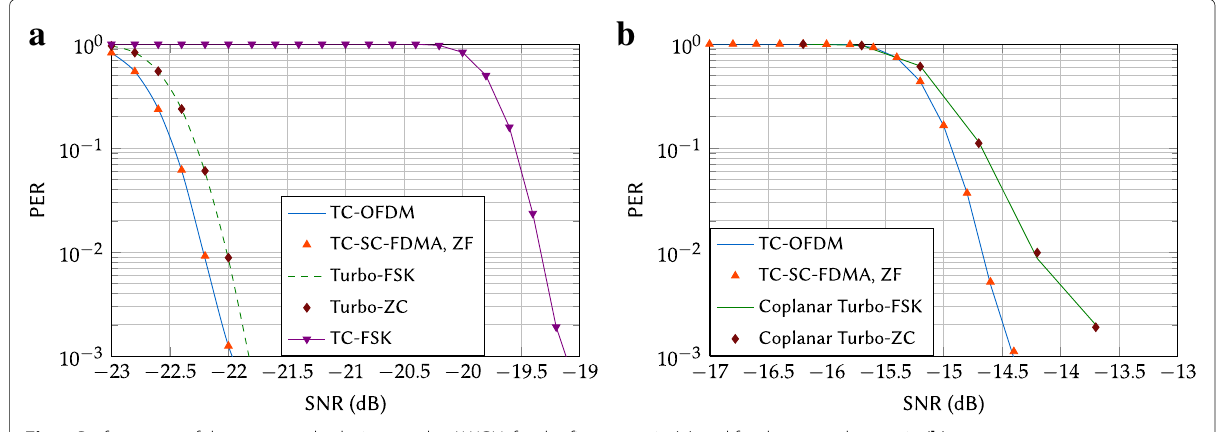
Fig. 4 Performance of the compared solutions under AWGN, for the first scenario ( a ) and for the second scenario ( b